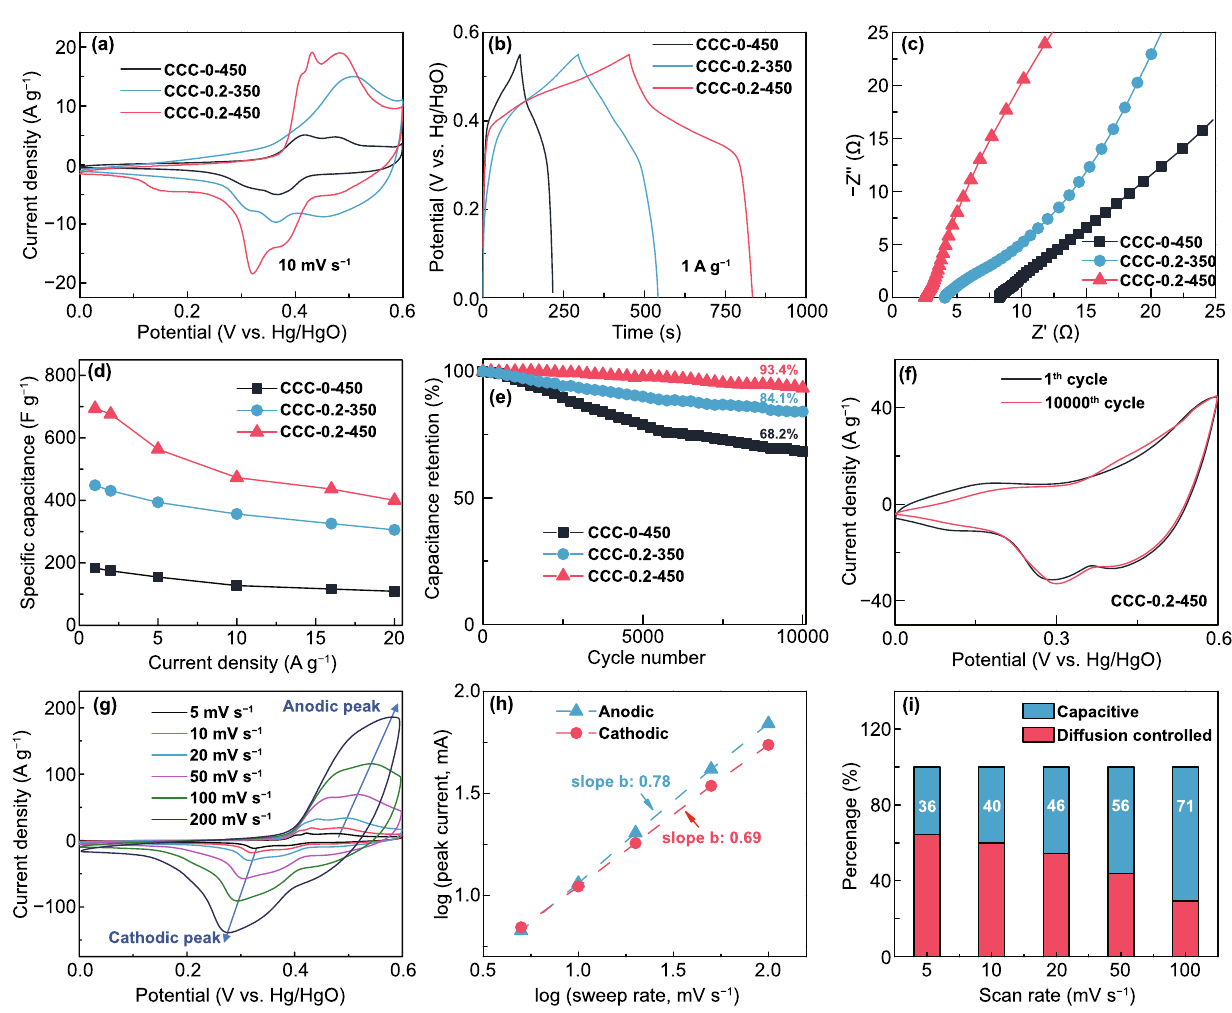
Fig. 3 Comparison of electrochemical performances of pristine CoO (CCC-0-450), Cu + -doped CoO (CCC-0.2-350), Cu 0 /Cu + co-doped CoO (CCC-0.2-450) in a three-electrode configuration: a CV curves, b GCD curves, c EIS plots, d specific capacitance, e cycling performance at 50 mV s −1 , f the 1st and the 10000th cycle CV plot of CCC-0.2-450 electrode. g – i CV curves, linear relation between log ( v ) and log ( i ), and the contribution ratio of capacitive and diffusion-controlled process in